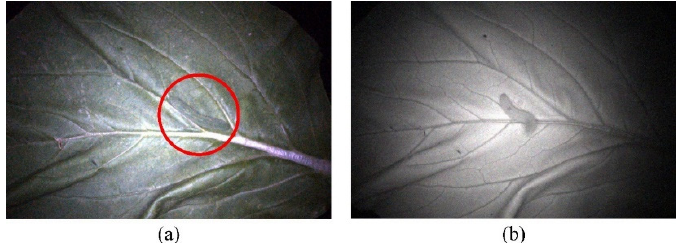
Figure 1. Comparison of near-infrared imaging effects of Pieris rapae on cabbage leaves. ( a ) The original image. ( b ) Near-infrared image. In the process of image acquisition, P. rapae and cabbage leaves were placed in a black box and an 850 nm infrared filter was installed on the camera to collect near-infrared images with an 850 nm ring light source. The original image is not equipped with a filter but is equipped with a white ring light with the same power as the 850 nm.